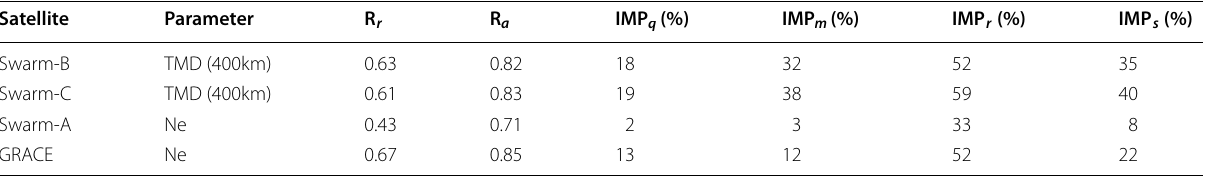
Table 1 Summary of TMD and electron density (Ne) correlation coefficient of reference (R r ) and analysis (R a ) and RMSE improvement (IMP) for along the orbit of different satellites observations